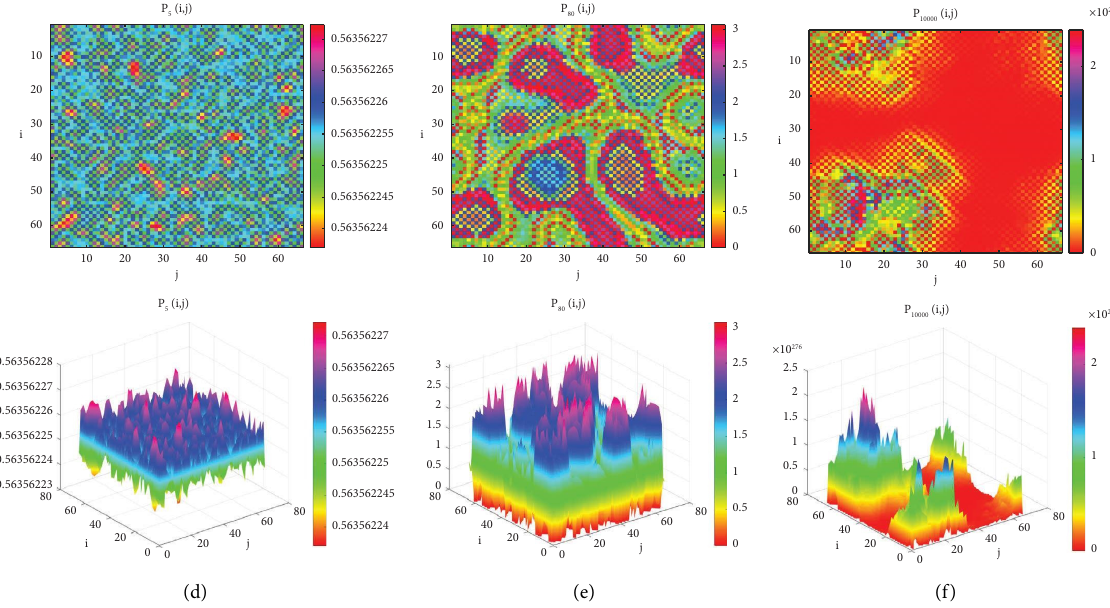
� 0 . 22, ( d , σ ) � ( 0 . 2 , 0 . 75 ) falls in the region II of Figure 7(c), which is consistent with 2 1